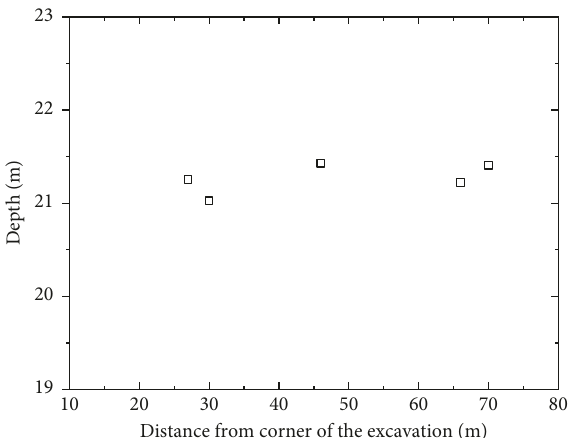
Figure 16: Depths of neutral points of Wulin Road